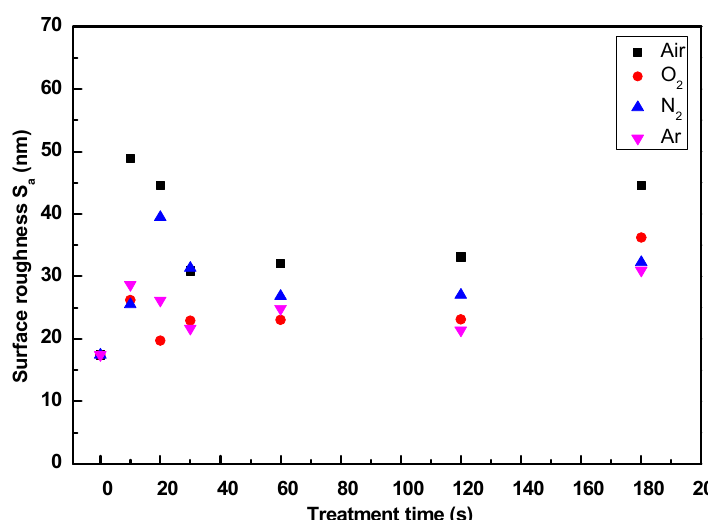
Figure 13. Surface roughness as a function of plasma treatment time for PU treated using air, O 2 , N 2 , and Ar.